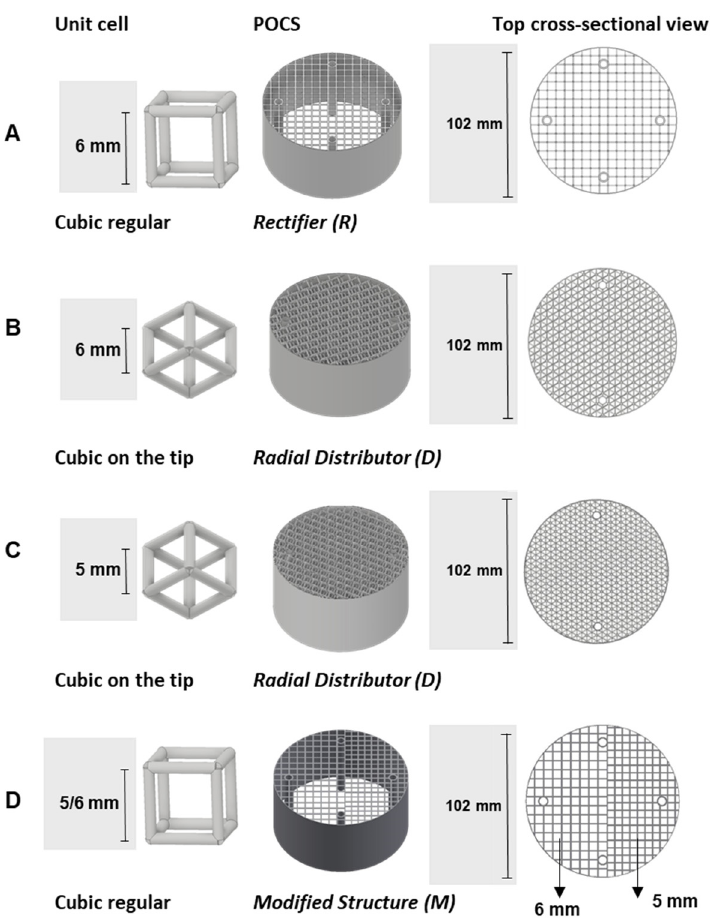
Figure 3. Investigated structures: ( A ) Cubic regular with a unit cell size of 6 mm, ( B ) Cubic on the tip with a unit cell size of 6 mm, ( C ) Cubic on the tip with a unit cell size of 5 mm, ( D ) Cubic regular with dissimilar sizes on either side (5 mm and 6 mm); all structures have a strut thickness of 1 mm. Cubic regular: The structures shown in Figure 3A,D have a lower flow resistance due to their open geometric pattern compared to the cubic on the tip oriented structures (cf.